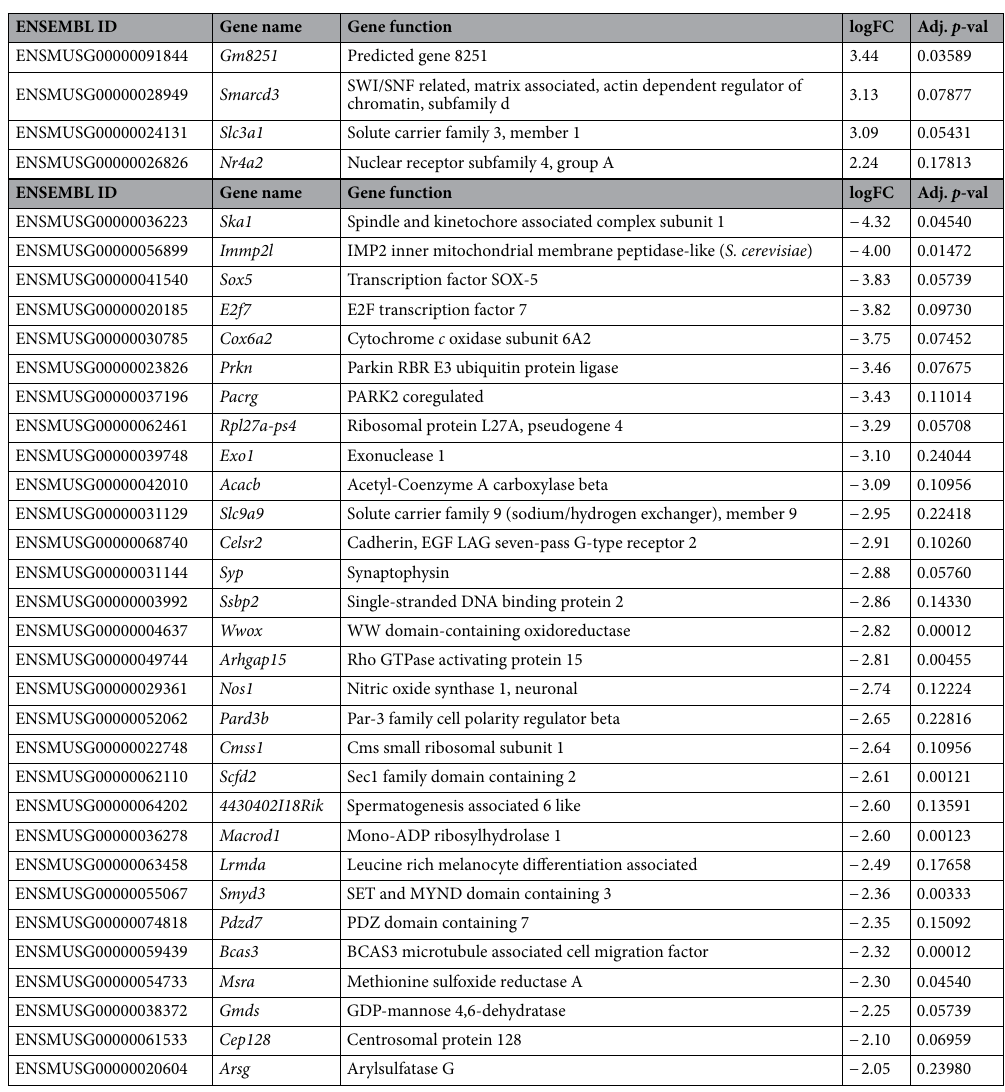
Table 1. Lists of DEGs in LPS-primed BMDMs in the presence of carboplatin, |log2FC| > 2, p <